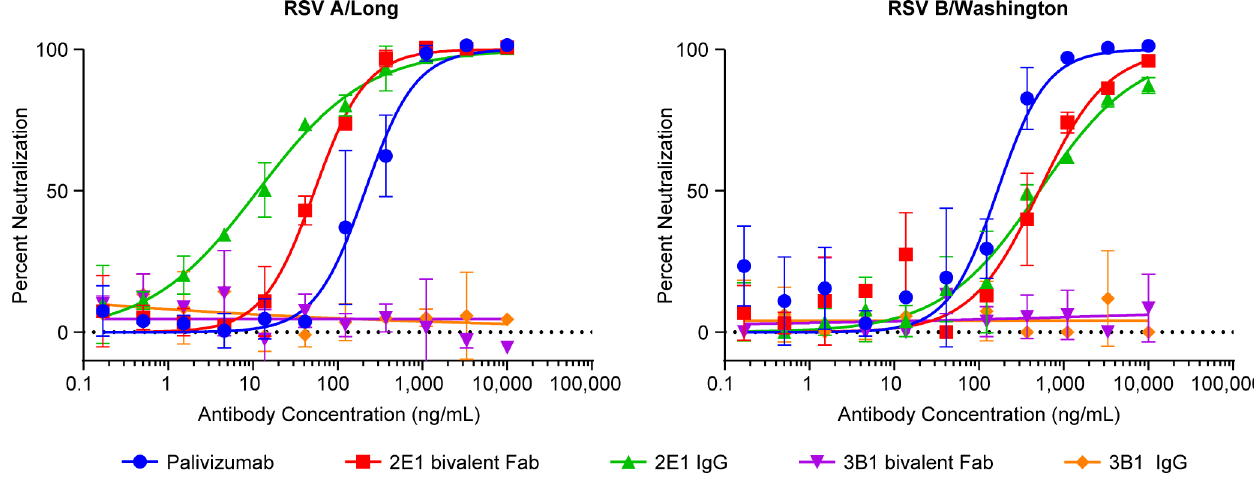
Fig 3. Neutralization of RSV by mAbs 2E1 and 3B1. Li-Cor based RSV micro-neutralization assay was performed. Neutralization curves against RSV A Long strain (A) and RSV B Washington strain (B) for 2E1, 3B1, and palivizumab are plotted with error bars representing the standard deviation from replicate data. 2E1 bivalent Fab is shown in red, full length IgG version of 2E1 shown in green, 3B1 bivalent Fab shown in purple, full length IgG version of 3B1 shown in orange, and palivizumab shown in blue.